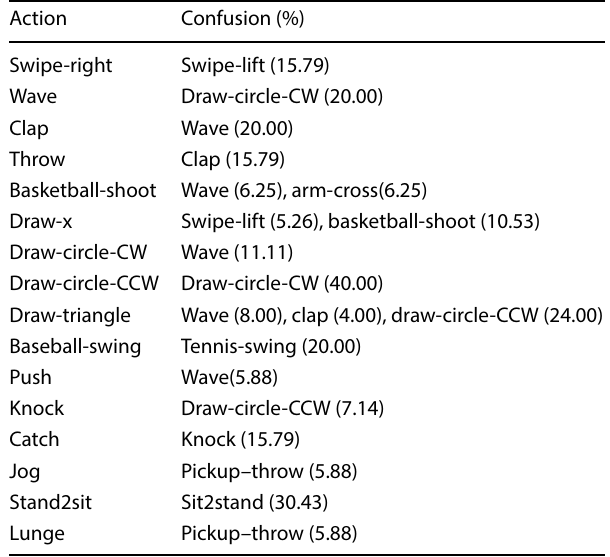
Table 6 Class oriented confusion on UTD-MHAD dataset